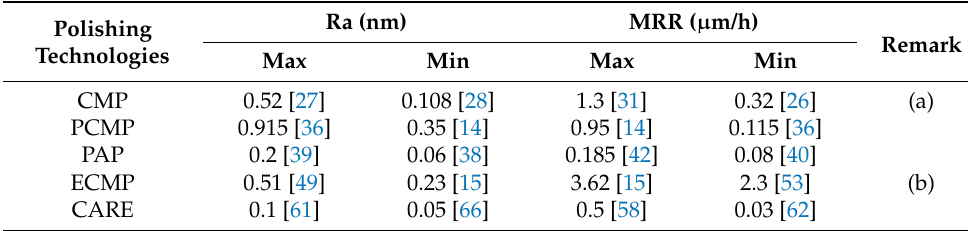
Table 2. MRR and Ra from the literature.